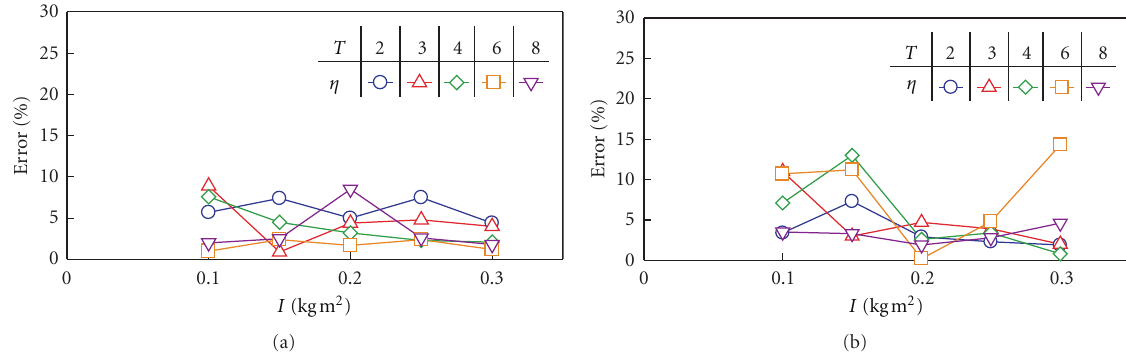
Figure 12: Experimental error of energy e ffi ciency for wind amplitude (a) Δ V = 1 and (b) Δ V = 2m/s.